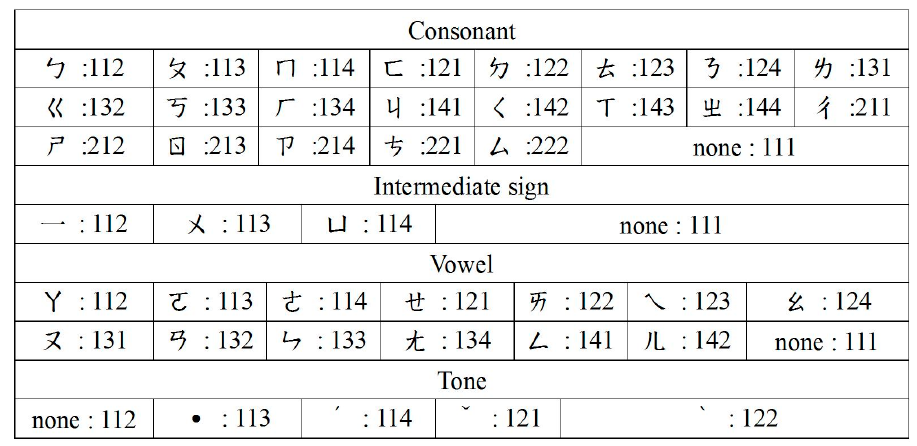
Figure 6. Two ‐ numeric ‐ code table of the Chinese phonetic alphabets.